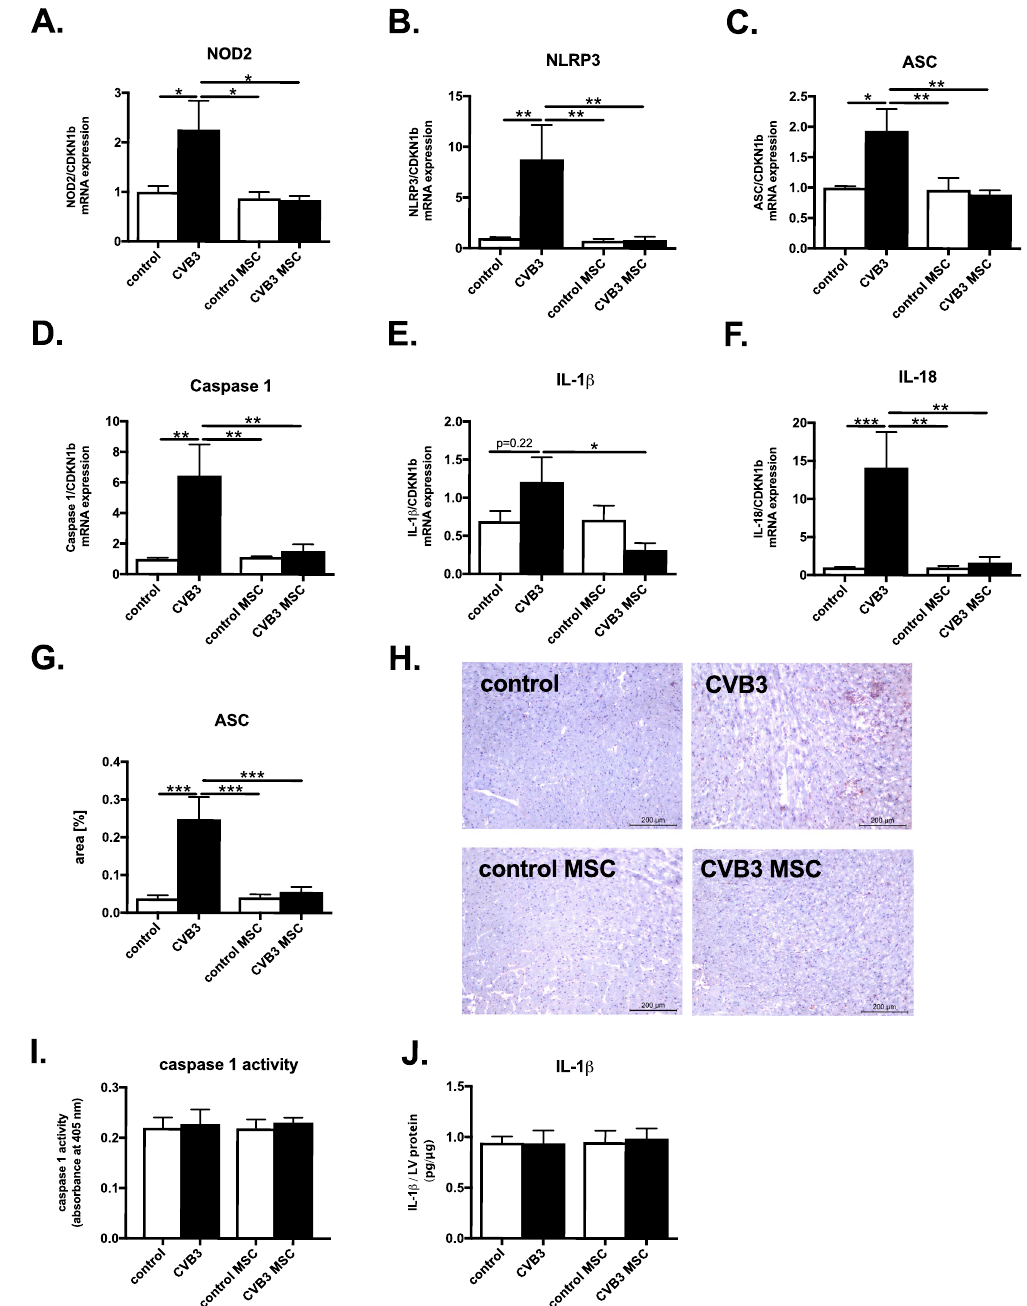
Figure 1. Mesenchymal stromal cells abrogate Coxsackievirus B3-induced expression of NOD2 and NLRP3 inflammasome components and products in the heart. Bar graphs represent the mean ± SEM of ( A ) NOD2, ( B ) NLRP3, ( C ) ASC, ( D ) Caspase 1, ( E ) IL-1 β and ( F ) IL-18 mRNA expression in the LV of control, CVB3, control MSC, and CVB3 MSC mice, as indicated, with n = 5–6/group and * p < 0.05 and ** p < 0.01. ( G ) Bar graphs represent the mean ± SEM of a quantitative analysis ASC positive area in the heart of control, CVB3, control MSC, and CVB3 MSC mice, as indicated, with n = 4–6/group and *** p < 0.001. ( H ) ASC expression in LV of control mice receiving PBS (upper left panel) or MSC (lower left panel), or of CVB3 infected mice receiving PBS (upper right panel) or MSC (lower right panel), detected by immunohistochemistry at a magnification of × 100. Bar graphs represent the mean ± SEM of ( I ) LV caspase 1 activity represented as absorbance at 405 nm and ( J ) IL-1 β protein expression, depicted as pg IL-1ß per µ g LV protein, determined in the LV of control, CVB3, control MSC, and CVB3 MSC mice, with n = in the innate immune response and is associated with cardiac injury by exacerbation of inflammation and car- diac remodeling 6 . NOD2 activates (NOD)-like receptor pyrin domain-containing 3 (NLRP3) inflammasome and IL-1 β processing and secretion 4 , primarily on phagocytic antigen-presenting cells such as macrophages and